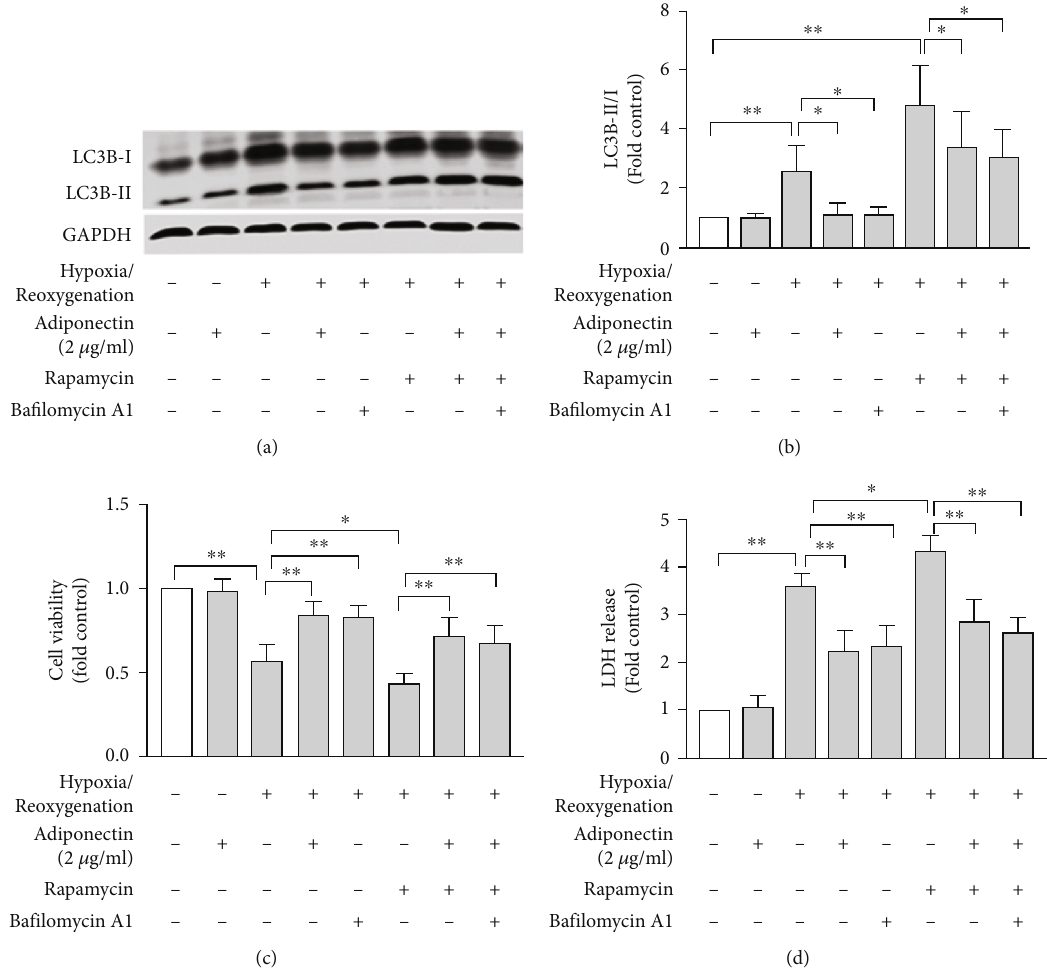
Figure 3: Adiponectin treatment attenuates rapamycin and hypoxia/reoxygenation-augmented autophagy in cardiomyocytes and has no additive e ff ect with vacuolar H + -ATPase inhibitor ba fi lomycin. Neonate rat cardiomyocytes were cultured at normoxia or hypoxia condition (12 hours) or underwent 12 hour-hypoxia/12 hours-reoxygenation in the presence of vehicle control, adiponectin (2 mg/ml), rapamycin (5 nM), or ba fi lomycin (100nM). Cell viability, cell injury, and the protein levels of LC3B-I and LC3B-II were determined by MMT, LDH release, and Western blotting analyses, respectively. (a) Representative Western blotting images for the proteins of LC3B-I, LC3B-II, and GAPDH in cells at di ff erent experiment settings. (b) Quanti fi cation of autophagy as the ratios of LC3B-II/LC3B-I in cardiomyocytes receiving di ff erential treatments ( n = 4 /group). (c, d) Mean and standard error of mean